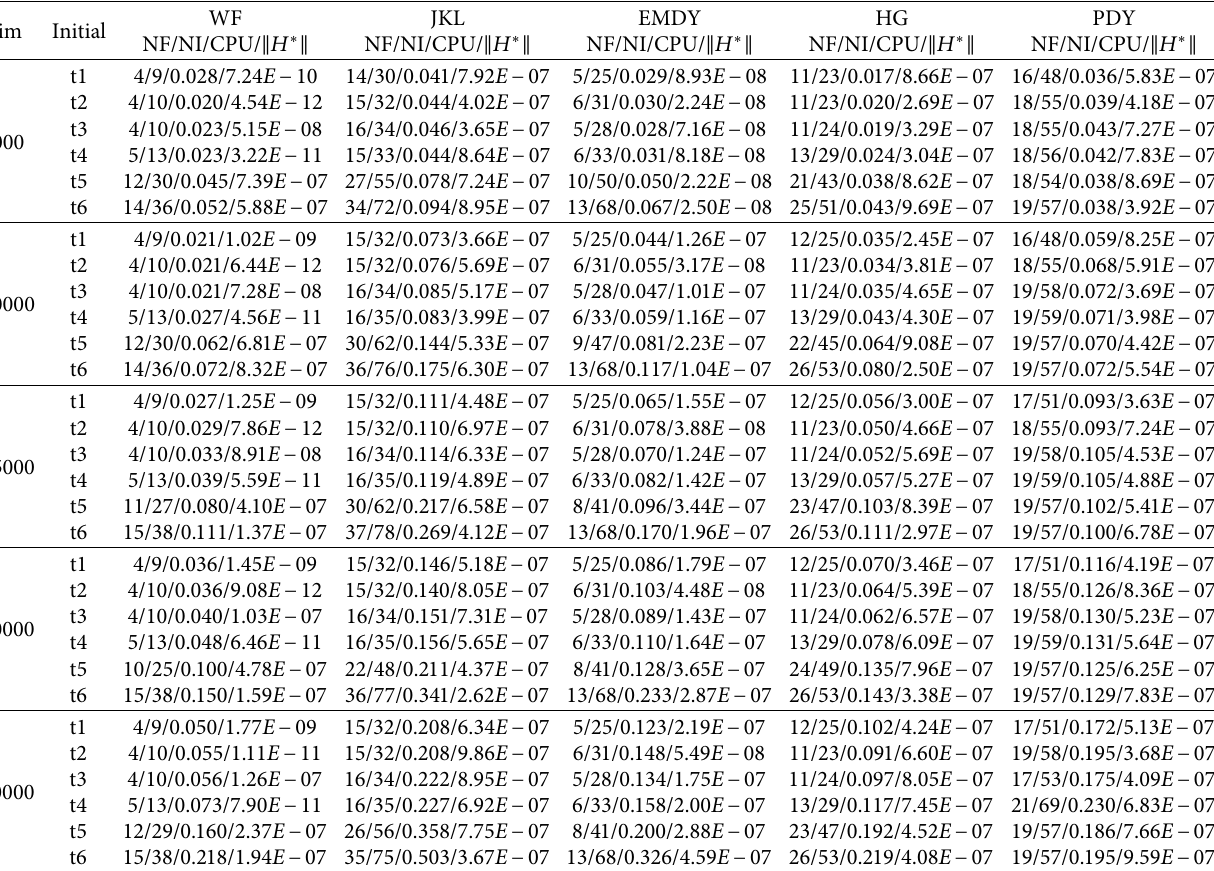
Table 1: Numerical results on problem 1.